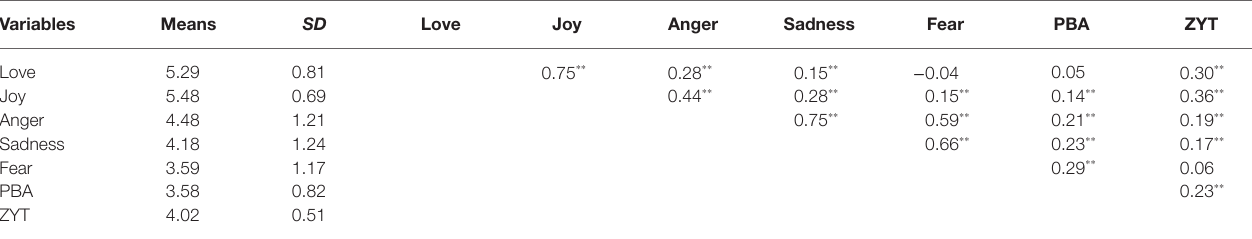
TABLE 3 | Means, SDs, and correlations. Variables